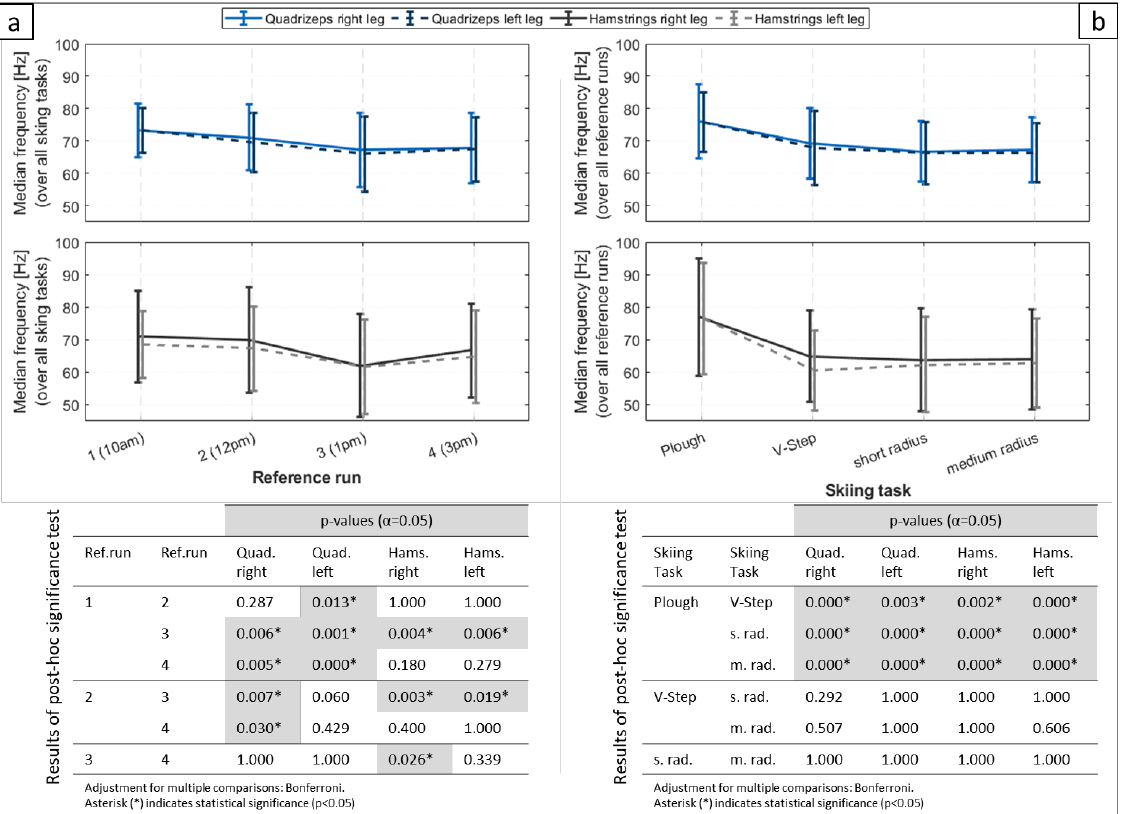
Figure 5. ( a ) graphs: Median frequency of the EMG over all skiing tasks for the four reference runs. The error bars indicate the standard deviation. ( b ) graphs: Median frequency of the EMG over all reference runs for the four different skiing tasks. The error bars indicate the standard deviation. The tables below each pair of graphs give the results of the post hoc significance test with a significance level of α = 0.05 .